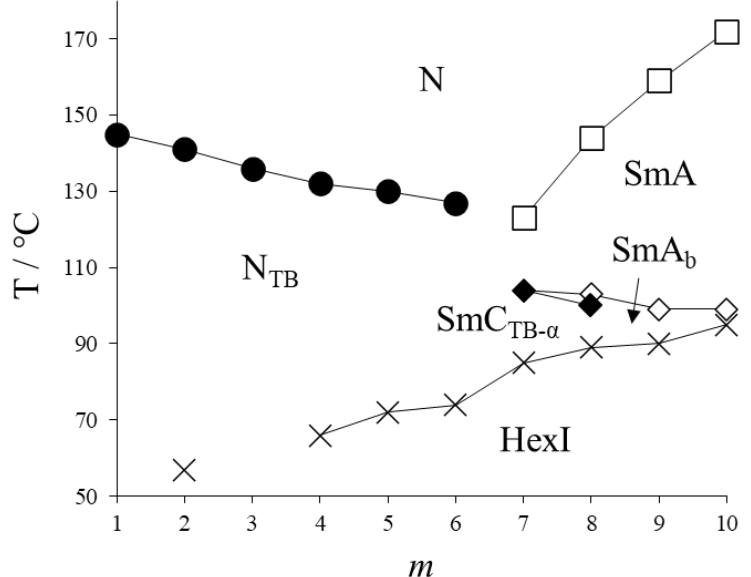
Figure 14. The dependence of the transition temperatures on the length of the terminal chain, m , for the CB6OIBeO m series [3]. The N-I transition temperatures have not been shown in order to enlarge the other phase regions. The melting points have been omitted for the sake of clarity. Filled circles denote T NTBN ; unfilled squares T SmAN ; unfilled diamonds T SmAbSmA ; filled diamonds T SmCTB- α SmAb ; crosses T HexI- .